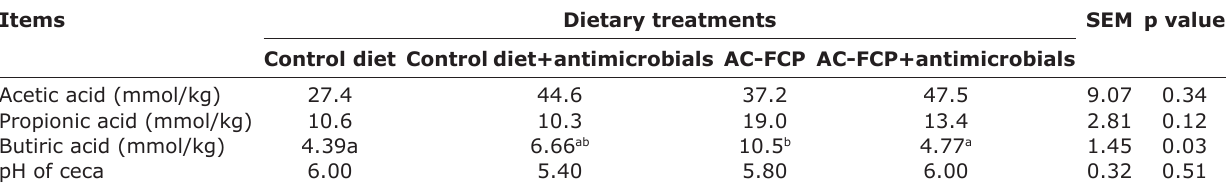
Table-3: Concentrations of SCFA and pH of cecal digesta of broilers fed the treatment diets. Items Dietary treatments